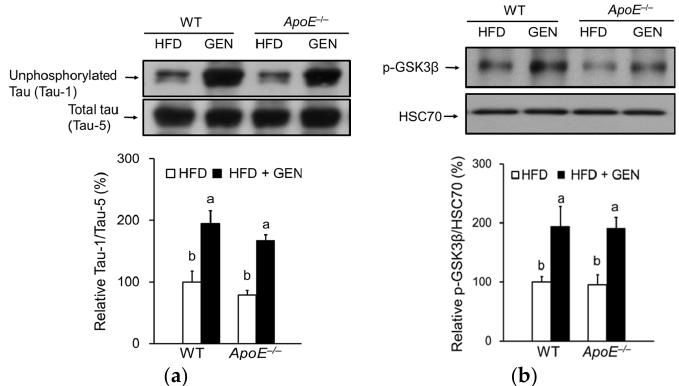
Figure 6. Effects of genistein on tau hyperphosphorylation in the cortex and hippocampus of WT and ApoE − / − mice fed an HFD. ( a ) Relative protein levels of unphosphorylated tau were analyzed by immunoblotting and were normalized to total tau ( n = 3); ( b ) relative protein levels of phosphorylated glycogen synthase kinase 3 β (GSK-3 β ) were analyzed by immunoblotting and were normalized to heat shock cognate protein (HSC) 70 ( n = 3). Each bar represents the mean ± SEM, and bars with different superscripts are significantly different at p <